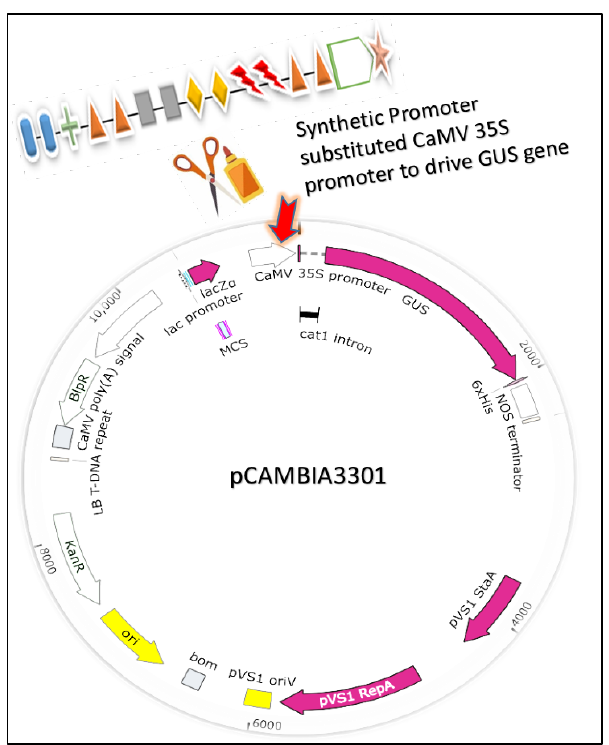
Figure 4. Schematic representation of the construction of expression cassette. Synthetic promoter was